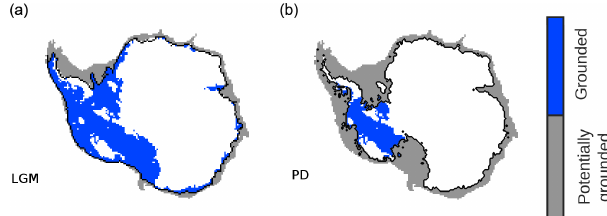
Figure 2. Mask used to evaluate grounding line migration. (a) Ice extent after glacial spin-up and (b) PD ice extension. Blue zones are model grid cells with grounded ice in marine zones. Grey zones are model grid cells without grounded ice in marine zones but the underlying bathymetry is shallow enough to potentially become grounded (i.e., marine zones with depths less than 2000m). The thick black line indicates the grounding line